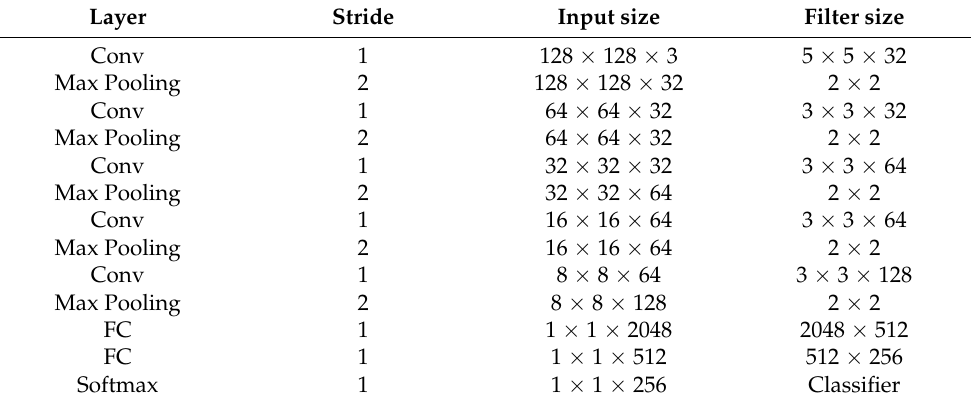
Table 3. The structure of the CNN